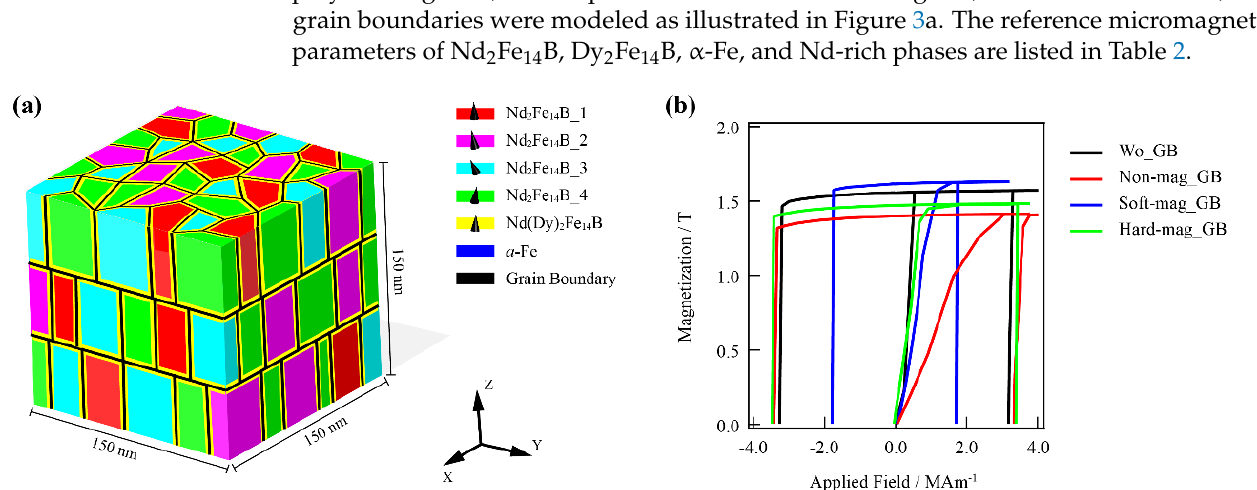
Table 2. Material parameters of each phase for micromagnetic simulations. α -Fe is the cubic struc- ture, and K1 is a typical anisotropy constant of the soft-magnetic phase [15].